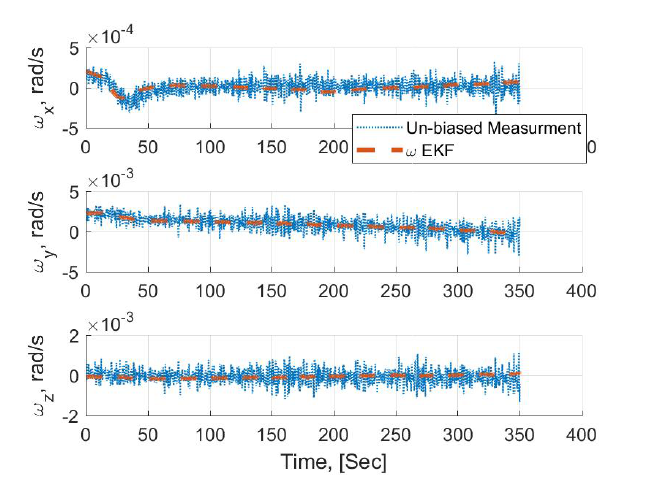
Figure 16. Angular velocities history from unbiased gyroscope measurements and the EKF output for 2nd maneuver.